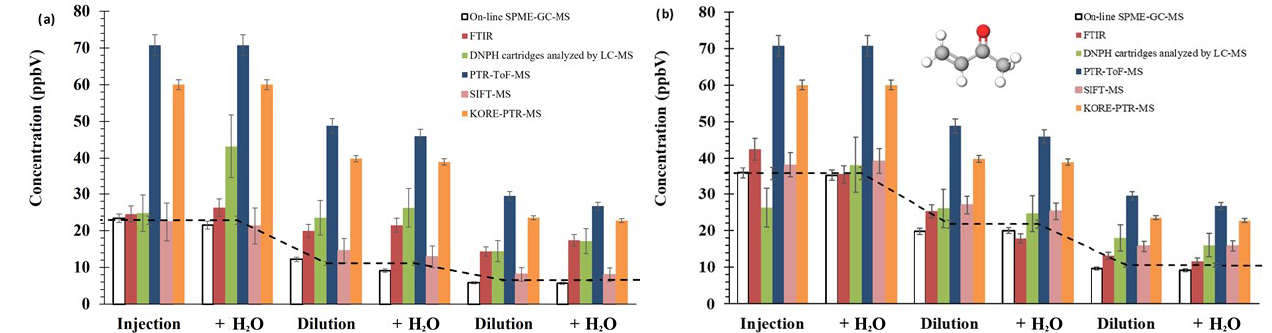
Figure 3. Average concentration of methacrolein (a) and methyl vinyl ketone (b) for all compared techniques: on-line SPME–GC–MS, FTIR, DNPH-LC–MS, Ionicon PTR-ToF-MS, SIFT-MS, and KORE-PTR-ToF-MS. Errors from SPME, FTIR, and DNPH-LC–MS include precision and accuracy; Ionicon PTR-ToF-MS, SIFT-MS, and KORE-PTR-ToF-MS errors consider 3 σ of precision (did not include accu- racy).